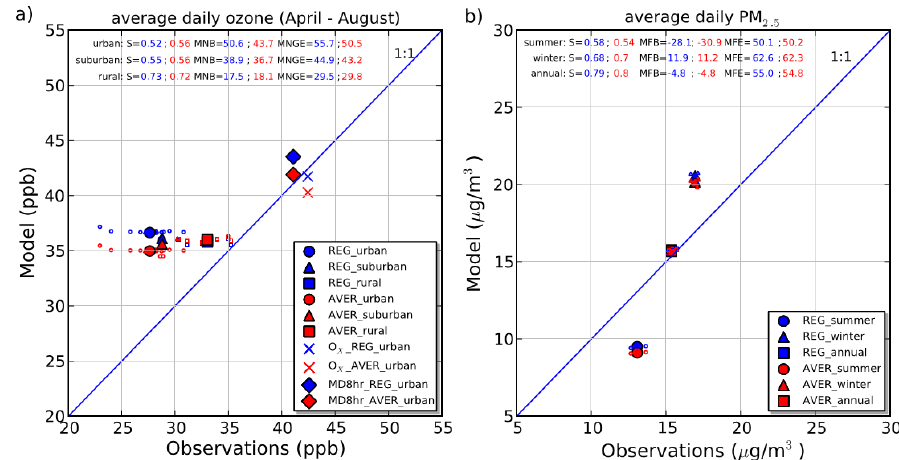
Figure 12. Scatter plots for the sensitivity test on model resolution for ozone and PM 2 . 5 .